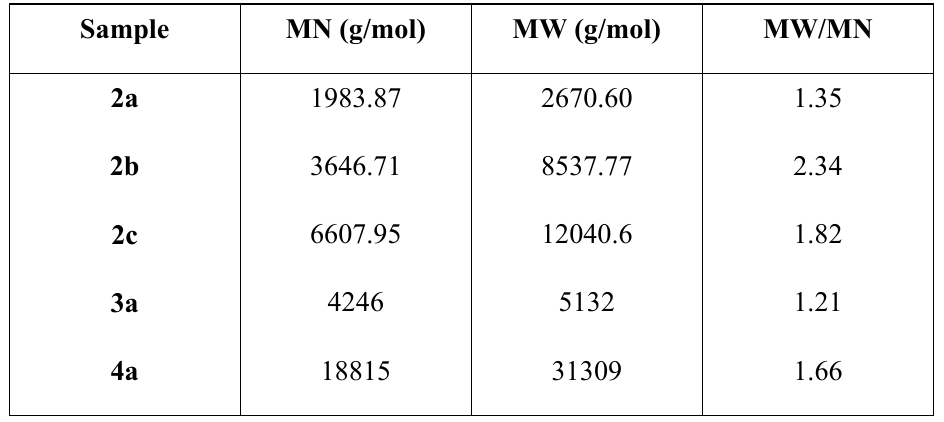
Table 2: Molecular weights of multiblock